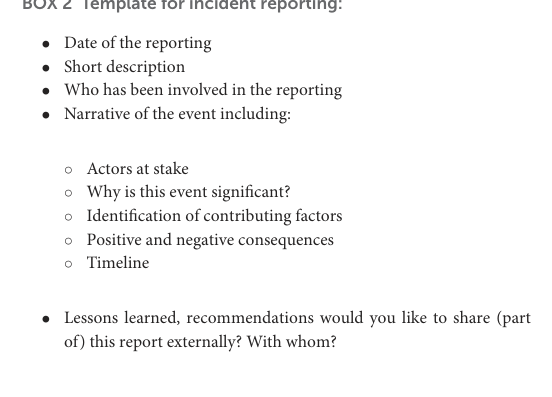
BOX 1 Assembling existing health data to assess the results of